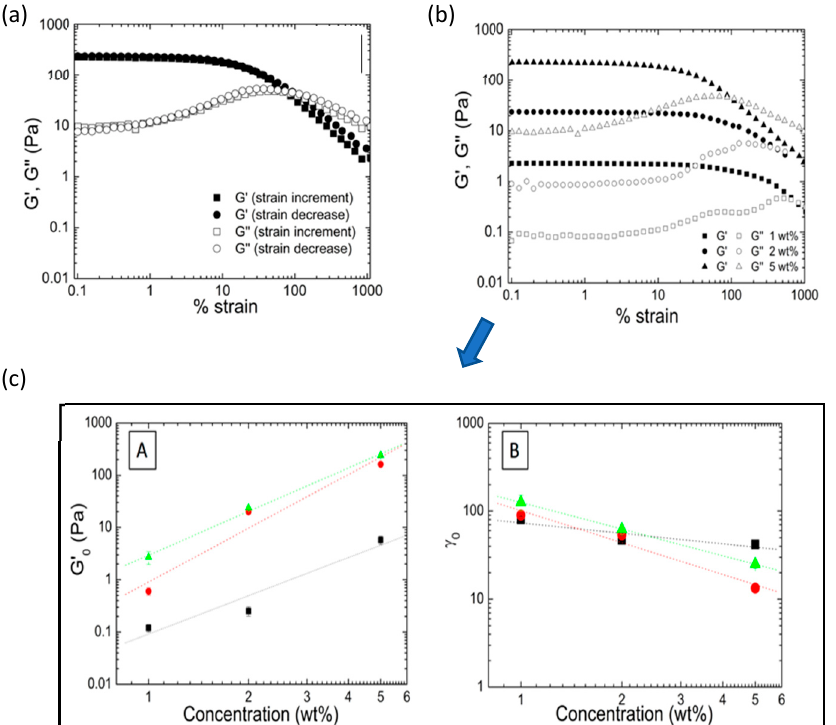
Figure 4. ( a ) Evolution of elastic (G’) and viscous (G’’) modulus as a function of % of strain determined as the strain increases and decreases. ( b ) Strain sweep test corresponding to microgel aqueous dispersion (1, 2, and 5 wt%) containing 10% of AuNP. ( c ) Double-logarithmic plots of the elastic modulus plateau G ′ ( A ) and critical strain γ c ( B ) as a function of microgel concentration. Adapted from Echeverria et al. [115] Nanomaterials, Oct 2019, 1499; DOI: doi.org/10.3390/nano9101499; licensed under CC BY 4.0 (open access). Table 1. Summary of the results obtained by applying Shih et al. and Wu and Morbidelli models to microgels’ systems containing Au and Fe 3 O 4 nanoparticles [115,116]. Slopes Shih et al. Samples